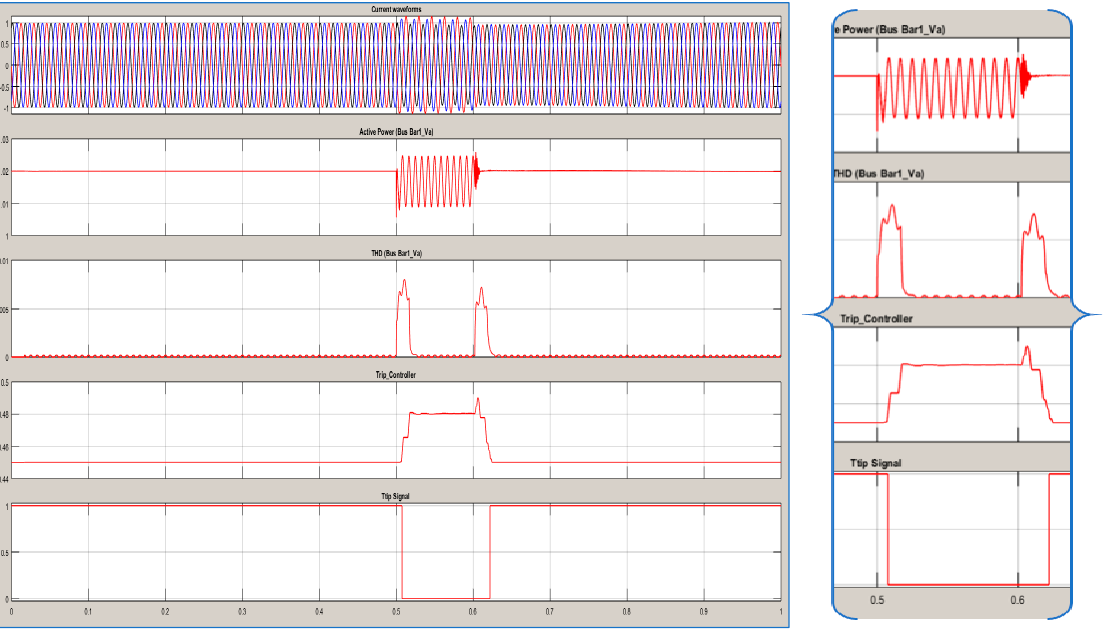
Figure 10. Single line to ground (A_G) fault current waveform.